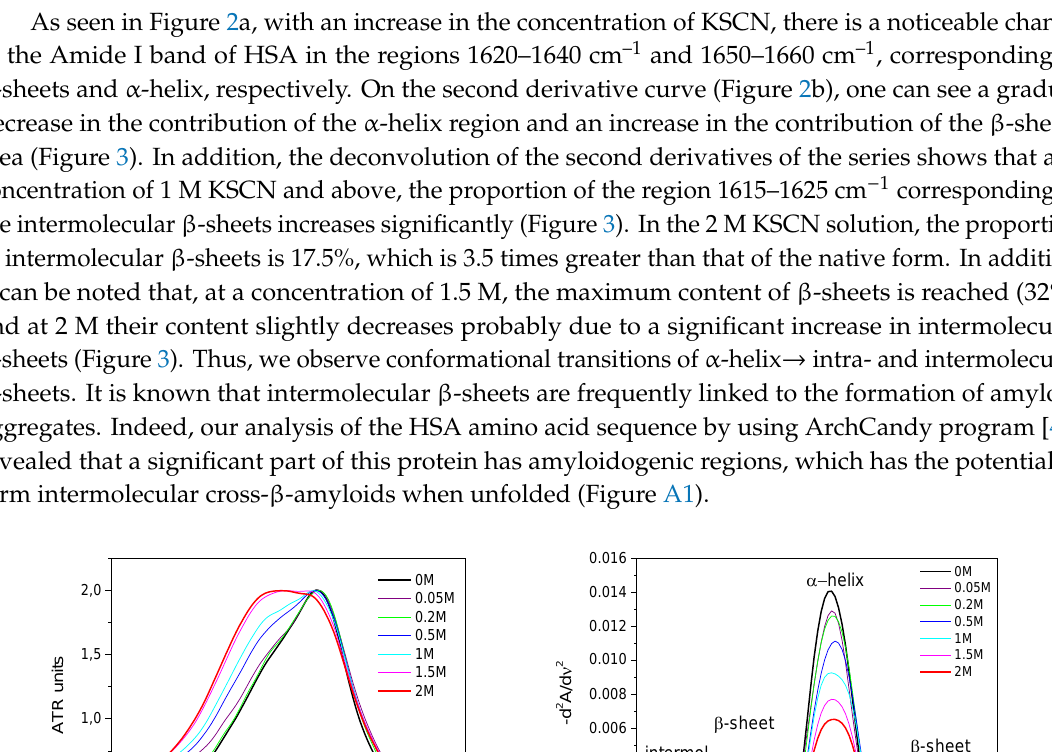
Figure 3. Potassium thiocyanate-induced conformational transition of HSA at 23 °C. Protein concentration was 10% wt. ( a ) ( b ) Figure 4. Changes in the character of the Amide I band ( a ) and changes in the second derivative of the Amide I band ( b ) of trypsin in 20% wt. aqueous solution at 23 °C with various concentrations of KSCN. Only the most representative curves are shown for the sake of clearness.